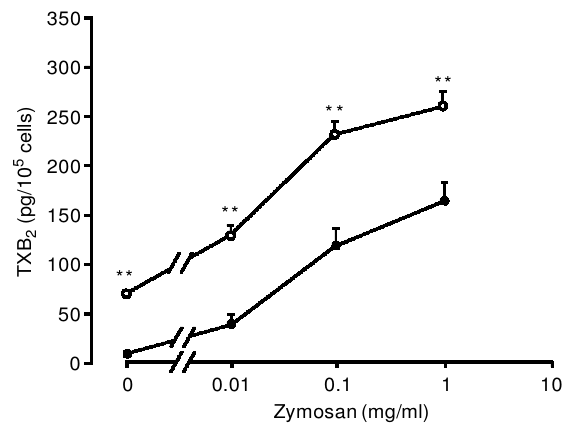
FIG. 1. TXB 2 production induced by opsonized zymosan (0.01 ± 1 mg / ml), for 1 h (® lled circles) or 4 h (open circles), from guinea-pig alveolar macrophages. P , 0.01, com- pared with the results obtained after 1 h of incubation. n > 6.